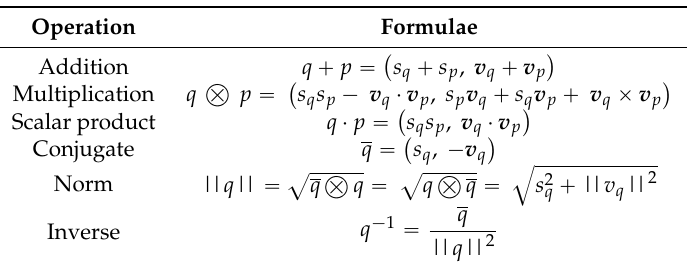
Table 1. Operations using quaternions q and p